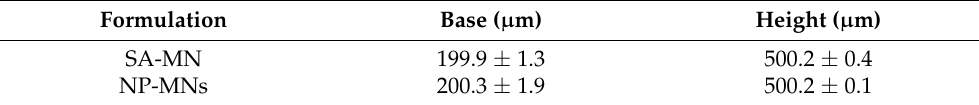
Table 2. Summary of microneedle dimensions ( n = 10, mean ±